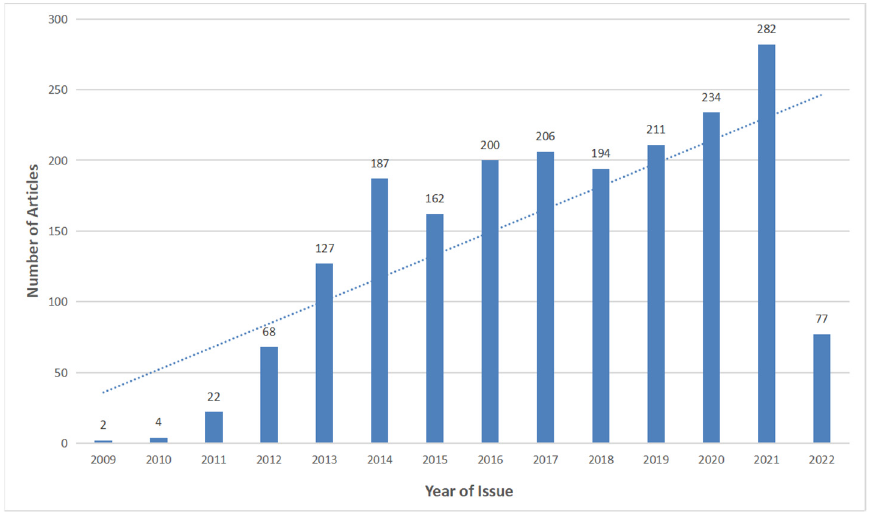
Figure 2. Time distribution chart.